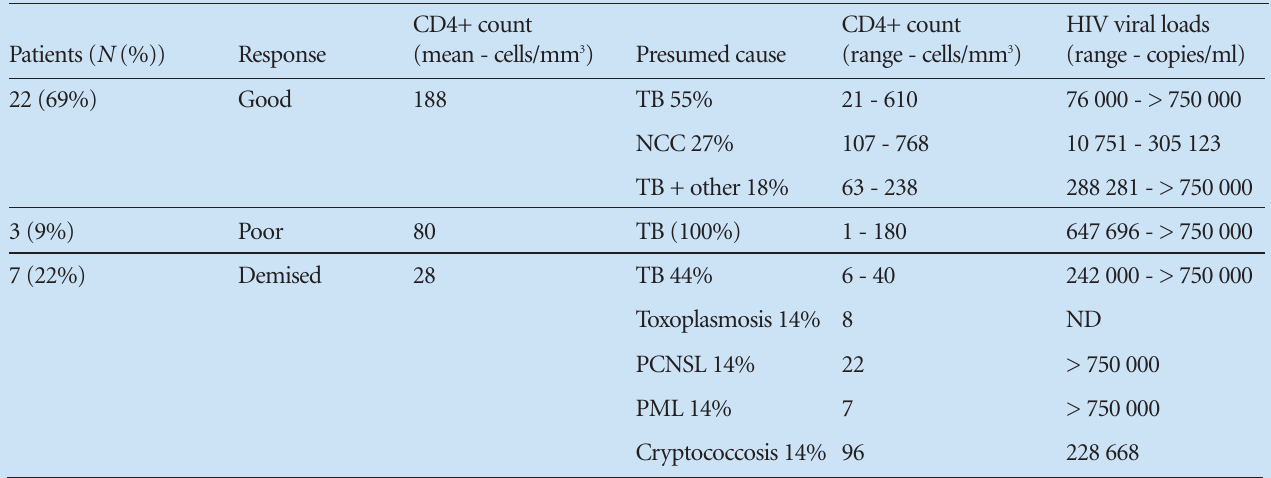
Table III.Treatment outcomes of focal brain lesions (FBLs) CD4+ count CD4+ count HIV viral